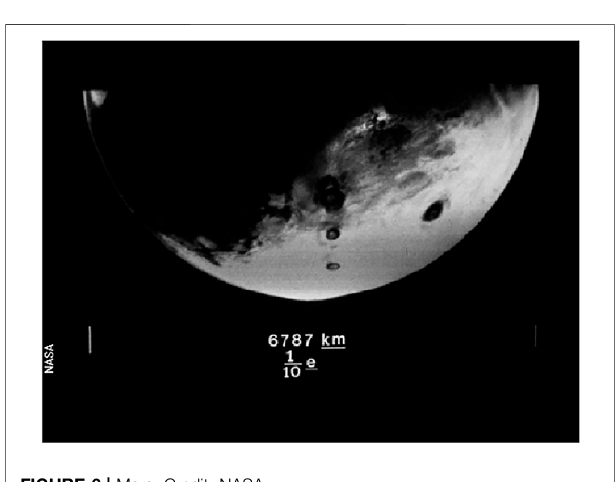
FIGURE 6 | Mars. Credit: NASA.